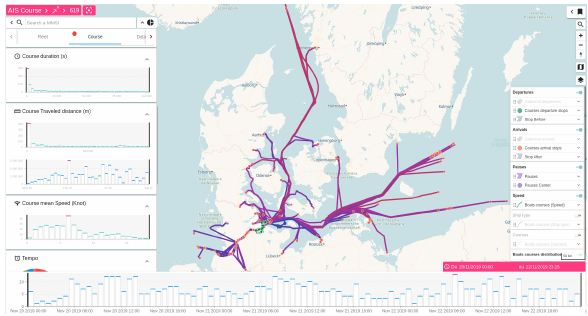
Figure 15 . Plots of ship routes from the port of Kiel in ARLAS Exploration